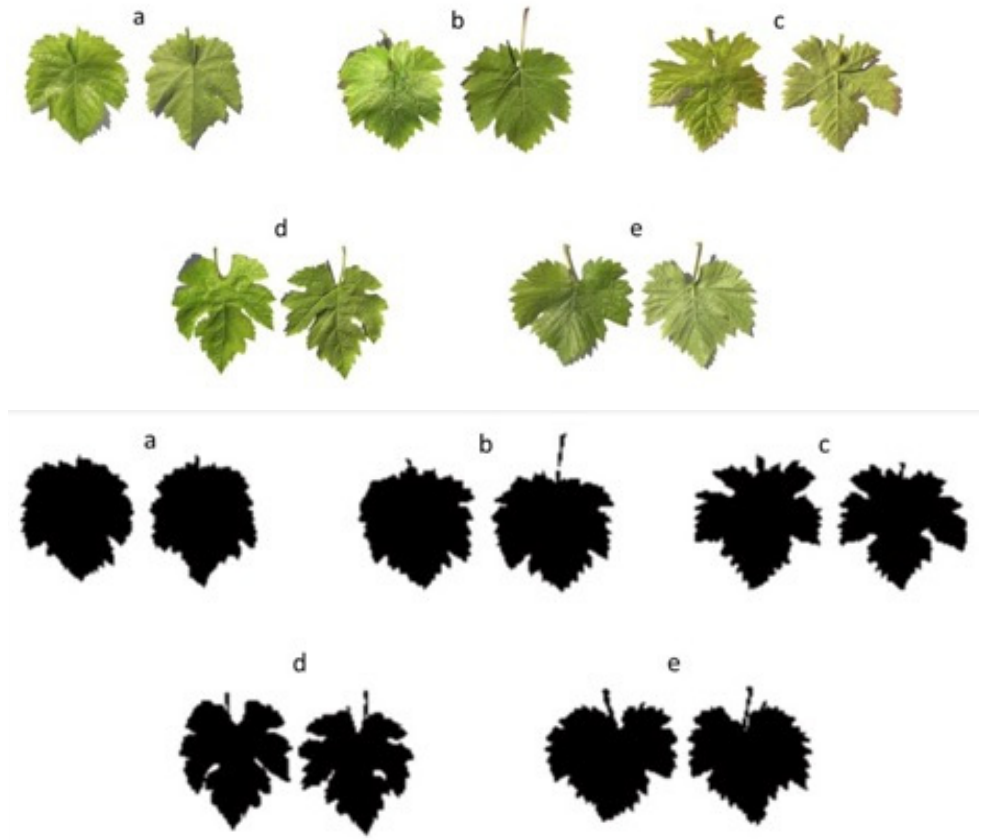
Figure 1. Example of scanned leaves of the 5 cultivars for the classification study ( up ) and corresponding binary images for automatic shape recognition ( down ) to obtain morpho-colorimetric parameters from each leaf. Letter of each leaf corresponds to ( a ) Sauvignon Blanc, ( b ) Chardonnay, ( c ) Carmenère, ( d ) Merlot and ( e ) Pinot Noir. Leaf sizes in the Figure are not proportional to real values. The obtained images were analyzed by using a customized code written in Matlab ® ver. R2010a (Mathworks Inc., Natick, MA, USA). The blue band of the image was then post-processed to identify the leaf morpho-colorimetric and fractal dimension variables (Figure 1). As described by Fuentes et al. [6], an initial calibration for the scanner was made using black squares as references of known dimensions to relate pixel count in the x and y coordinates to dimensions and area using metric units (cm and cm 2 ). Scanner cal- ibration allowed automatic analysis of leaf images, extracting morphometric and color parameters and the fractal dimensions of each leaf sample [6]. These variables were ana- lyzed according to the protocols stated by Fuentes et al. [6]. The parameters obtained from this process are presented in Table 1. Table 1. Description of the leaf morpho-colorimetric features for variety characterization and discrimination. Parameter RGB scale used to measure color: R = red, G = green, B = blue colors and RG = red and green index Fractal dimension (FR) Unitless Fractal dimension measured using the box-counting method 2.5. Plant Water Status and Gas Exchange Measurements The leaf water potential ( Ψ leaf) was measured to define the treatments. This param- eter was determined by using a pressure chamber (PMS Instrument Co., model 600, Cor- vallis, OR, USA), according to the methods stated by Acevedo-Opazo et al. [16] and by Jara-Rojas et al. [17].